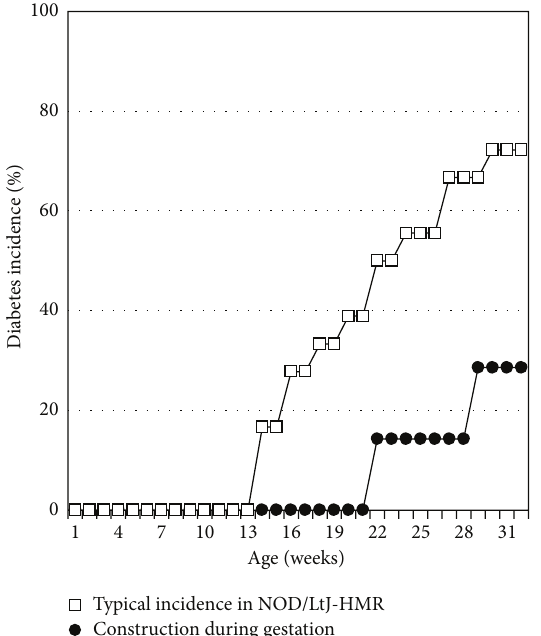
Figure 1: Nearby construction during the gestation period impacts diabetes onset and cumulative incidence in offspring. Depicted is a typical cumulative incidence of diabetes for eighteen female NOD/LtJ-HMR mice (open squares). Two NOD/LtJ-HMR female mice were in gestation while asphalt and sidewalk repairs were being carried out immediately outside the facility. The incidence of diabetes was closely monitored in the seven female offspring from these mothers (closed circles), where the onset is observed at 22 weeks of age and the cumulative incidence reaches approximately 30% at 32 weeks of age. Log-rank test, P value < 0.05.